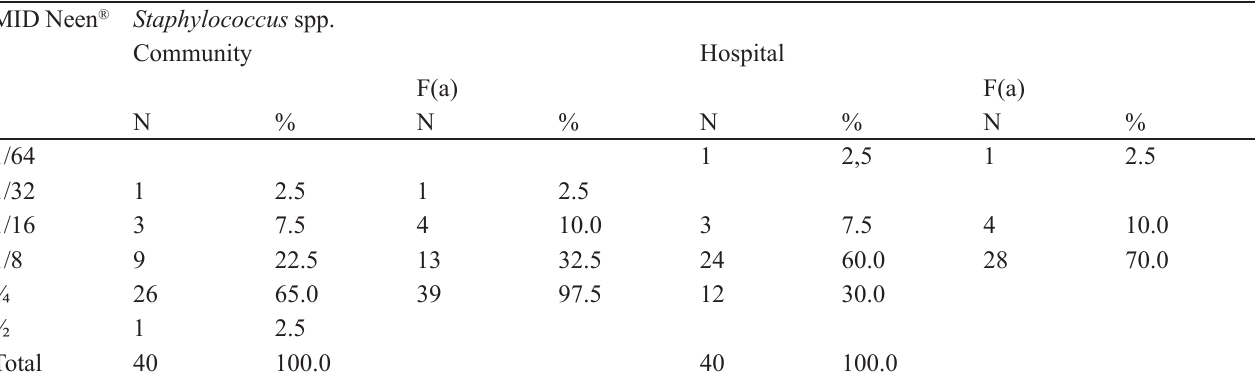
TABLE III - Numbers, Percentages and Accumulated frequency F(a) of the MID of Neen ® (N) as to Staphylococcus spp. isolated in the saliva of individuals from the community and hospital. Ribeirão Preto. 2006 MID Neen ® Staphylococcus